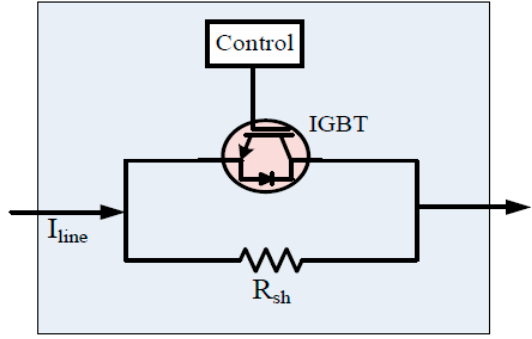
Figure 17. Structure of series dynamic braking type.